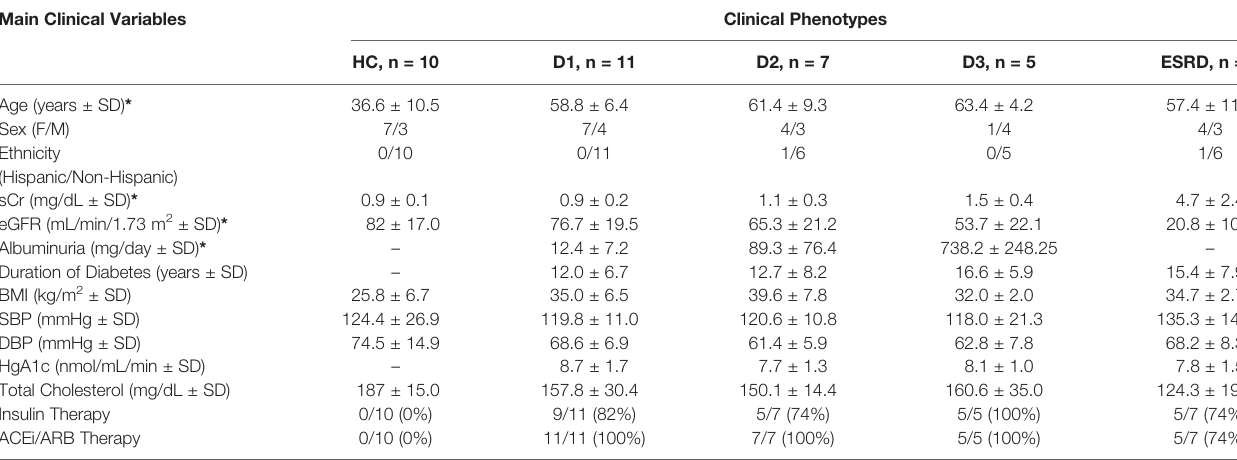
TABLE 1 | Demographic information for Cohort